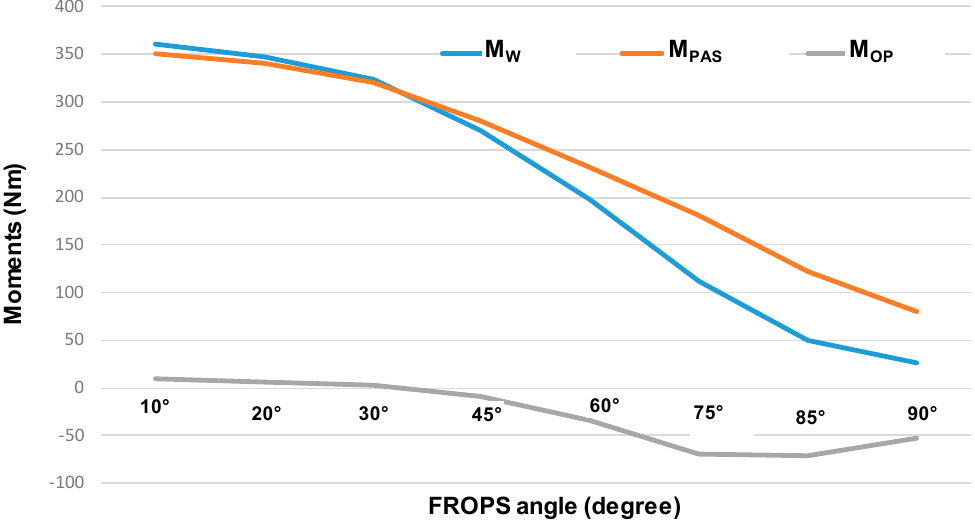
Figure 12. Variation of the moments involved in the FROPS handling in relation to the FROPS angle.